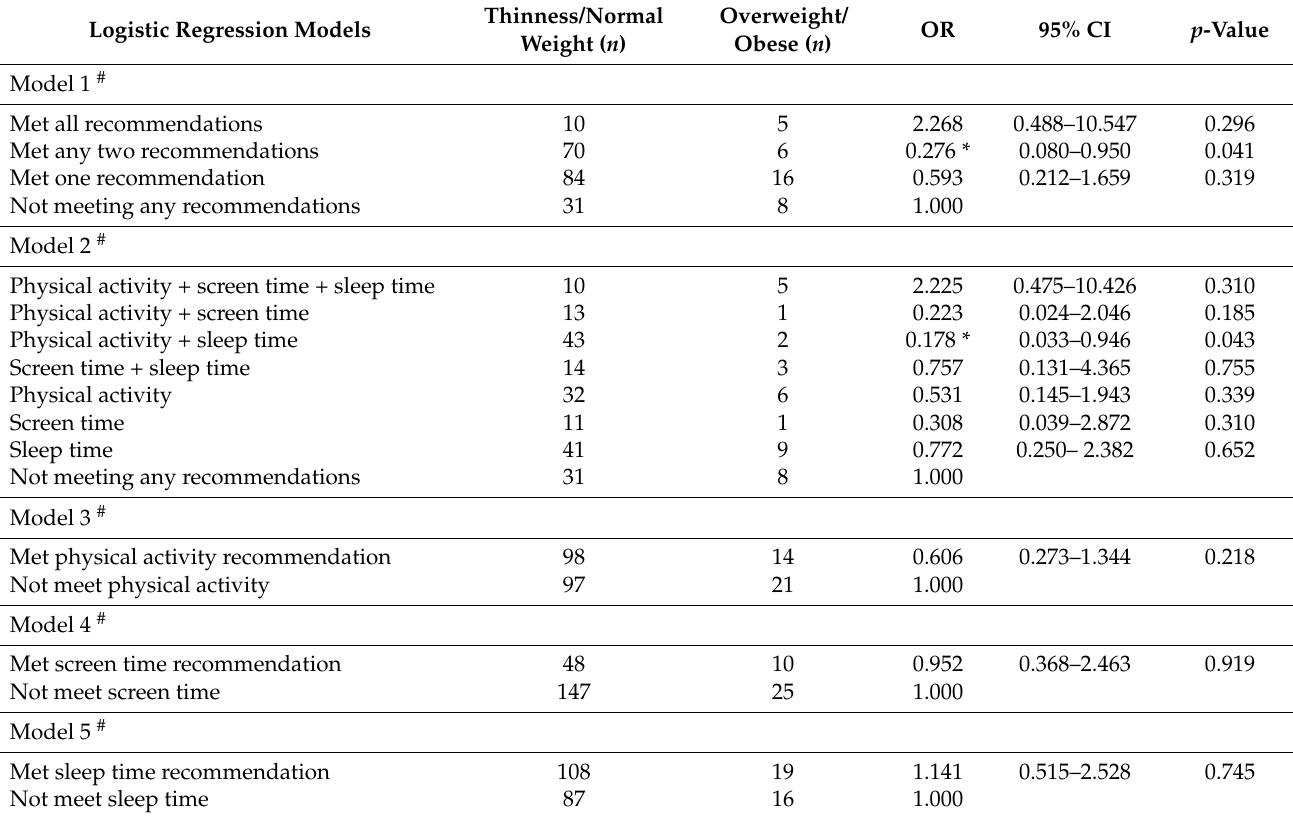
Table 3. Association of movement guidelines compliance with overweight or obese